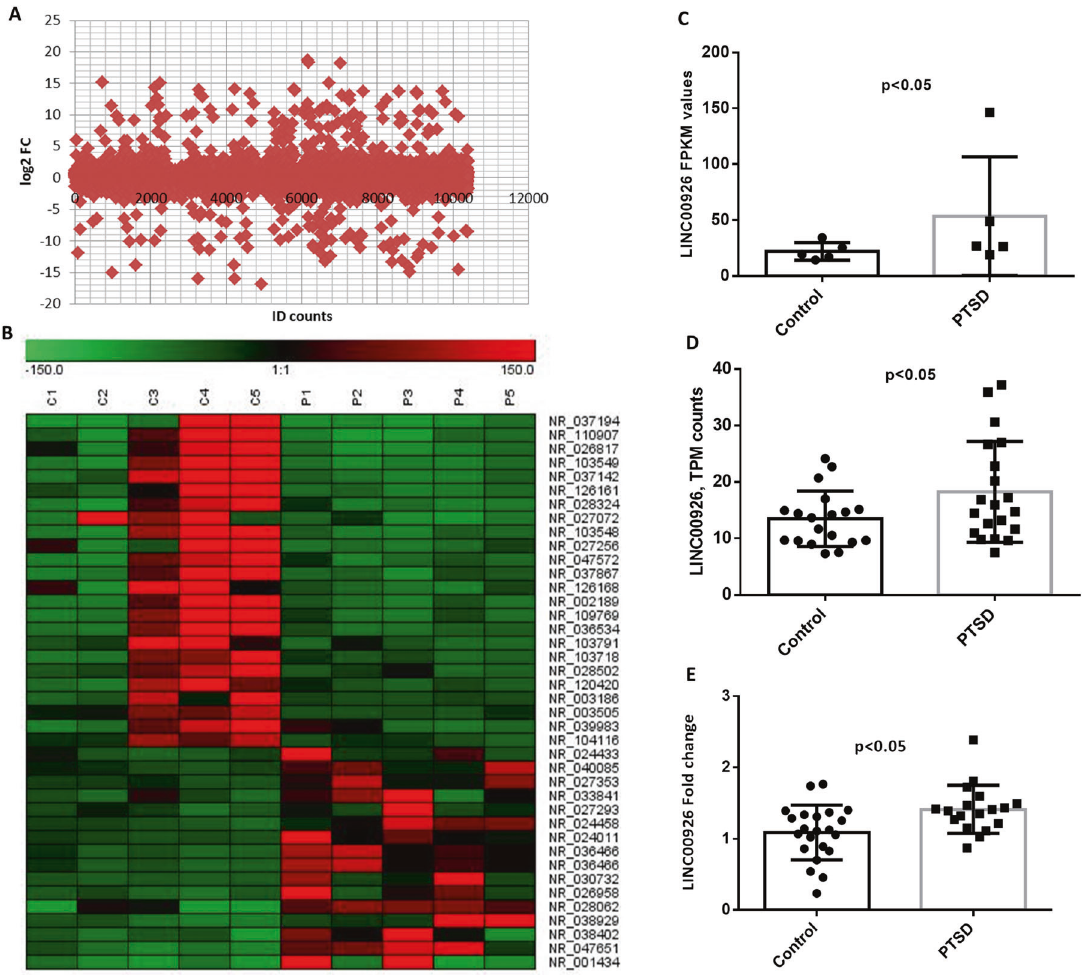
Fig. 1 Expression of noncoding RNAs in the PBMCs of PTSD patients. RNAseq was performed on total RNA from controls and patients. Only noncoding RNA differential expression was analyzed. A Scattered plot showing all the noncoding RNAs with at least 1 FPKM after RNAseq analysis. B Heatmap of only signi fi cantly dysregulated lncRNAs in PTSD. The labels on the right side indicate the NCBI accession numbers of the corresponding lncRNA. We then focused on the expression of LINC00926 for our further studies. C Expression of LINC00926 in PTSD patients ’ PBMCs from our RNAseq analysis. P value was obtained from the tool to analyze the RNAseq data. D RNAseq data from GSE114407 was used to analyze the expression of LINC00926 in PTSD patients PBMCs and the fi gure depicts the TPM values obtained from the dataset where the p value was obtained after performing Student ’ t test. Then we validated the expression of LINC00926 in PBMCs by performing qRT- PCR E . (FPKM: Fragments Per Kilobase of transcripts per Million mapped reads; TPM: Transcripts per million; Each dot in the plots represents an individual sample included for the